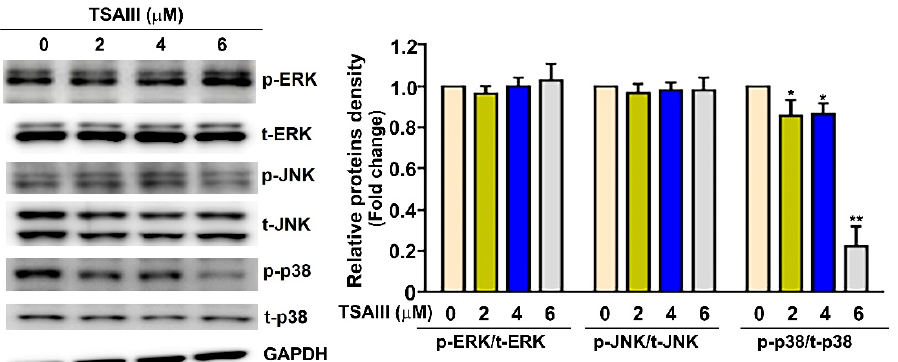
Figure 5. TSAIII downregulates the p38 MAPK signaling pathway in human SiHa cervical cancer cells. Human SiHa cervical cancer cells were treated with TSAIII (0, 2, 4 and 6 µM) for 24 h. SiHa cells were then harvested for use in immunoblotting assay to observe the activation of signaling pathway. GAPDH as internal control. * p < 0.05 ** p < 0.01 versus control (line 1) (mean ± SE, n = 3). t: total; p: phosphoryled. Uncropped WB images were shown in Figure S1.